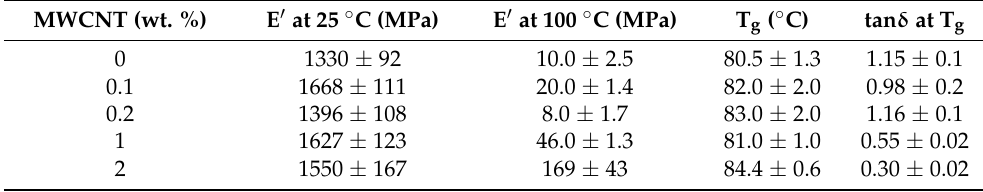
Table 3. Selected DMTA data for E (cid:48) , T g and tan δ of PET/MWCNT nanocomposites. MWCNT (wt.